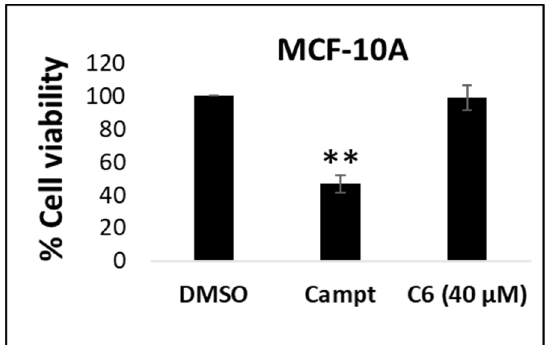
Figure 6. Screening of C6 in the non-cancerous breast cell line, MCF-10A, to evaluate its selectivity for breast cancer cells. ** p < 0.01. Camptothecin (5.74 µM) was used as a positive control to induce growth inhibition. Campt, camptothecin.